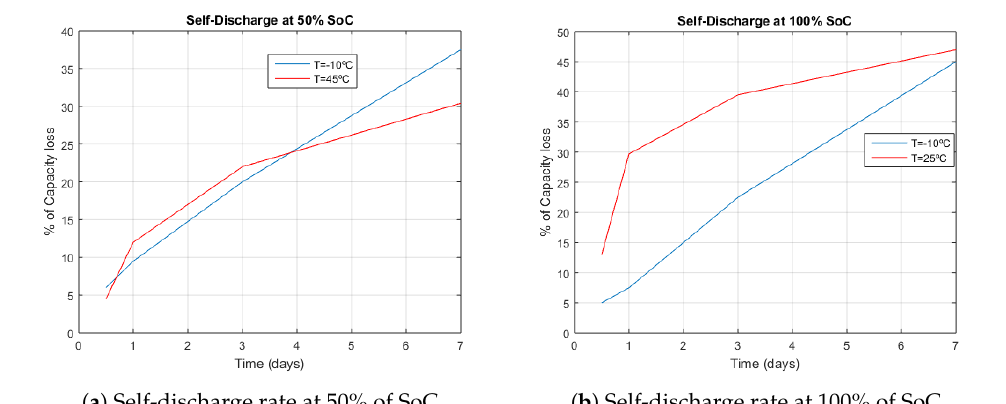
Figure 6. Self-discharge evolution at ( a ) 50% SoC and ( b ) 100%